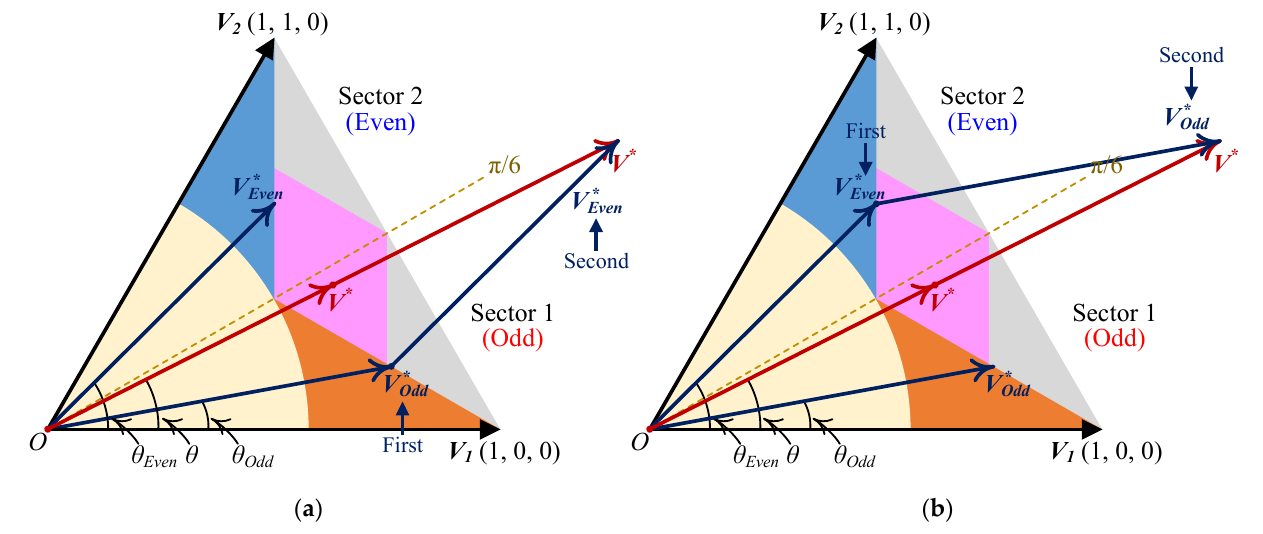
Figure 9. Vector synthesis method for reference voltage vector in vs. area of sector 1: ( a ) Odd-even vector modulation sequence; ( b ) Even-odd vector modulation sequence.